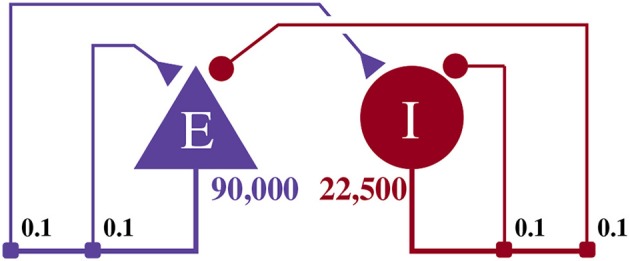
Illustration of the balanced random network model. The blue triangle represents the excitatory population, the red circle represents the inhibitory population, and the numbers beneath each symbol show the number of neurons in each population. Connection probabilities are shown in small bold numbers at the appropriate point in the connection matrix. All excitatory synaptic weights are initialized to 0.045 61 nA and all inhibitory synaptic weights are initialized to 0.228 05 nA.